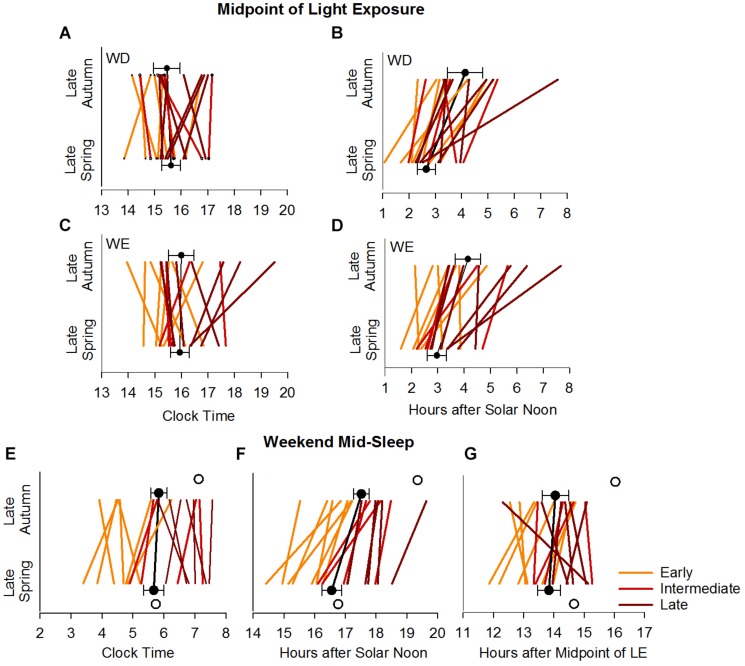
Midpoint of light exposure (50% LE) and weekend mid-sleep time in the late autumn and late spring. Upper panels show the individual and average weekday (A,B) and weekend (C,D) 50% LE times relative to clock time (A,C) and SN (B,D). Lower panels show the individual and average weekend mid-sleep times during the late autumn and late spring relative to clock time (E), solar noon (F) and midpoint of light exposure (G). In all the panels, individuals are color coded for early, intermediate and late bedtime categories. The filled symbols with error bars represent the average times with between subjects variance (SEM). The open symbols (lower panels) represent the model predicted average mid-sleep times.